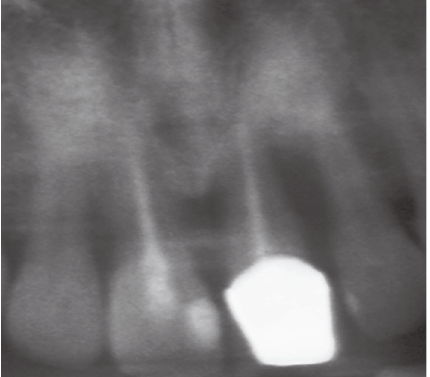
Figure 2: Section from panoramic radiograph representing the site of chief complaint, prior to the attempted extraction of the left maxillary central incisor. Severe vertical bone defect around the left maxillary central incisor is